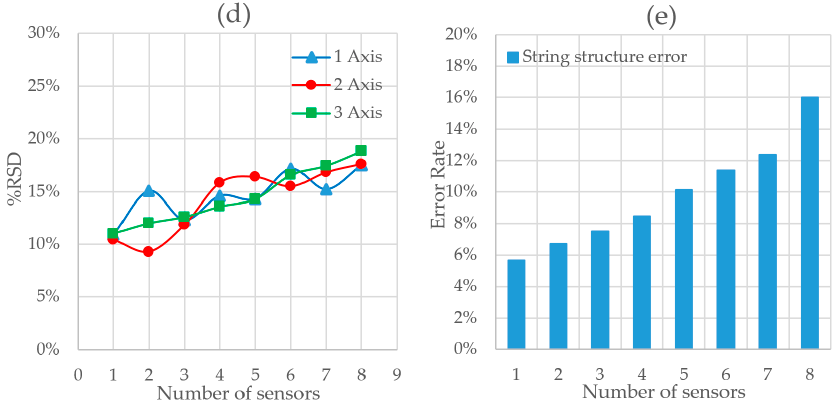
Figure 9. ( a ) Acquisition frequency depending on the number of sensors and axis read at the same time with Checksum method and 4 bytes of time, ( b ) total variation of the data acquisition frequency between Test 2 and Test 3, ( c ) percentage increase of the data acquisition frequency between Test 2 and Test 3, ( d ) acquisition frequency RSD depending on the number of sensors and axis read with Checksum, and ( e ) total error rate in Test 3.